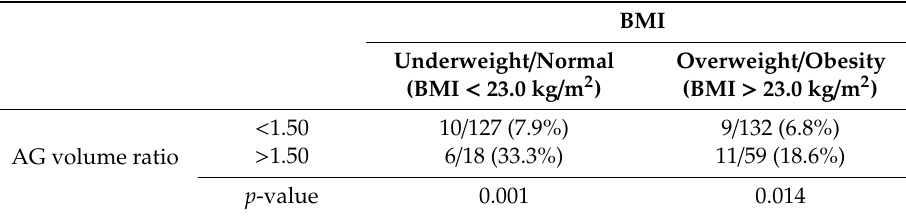
Table 4. Recurrence rates based on the combination of BMI and AG volume